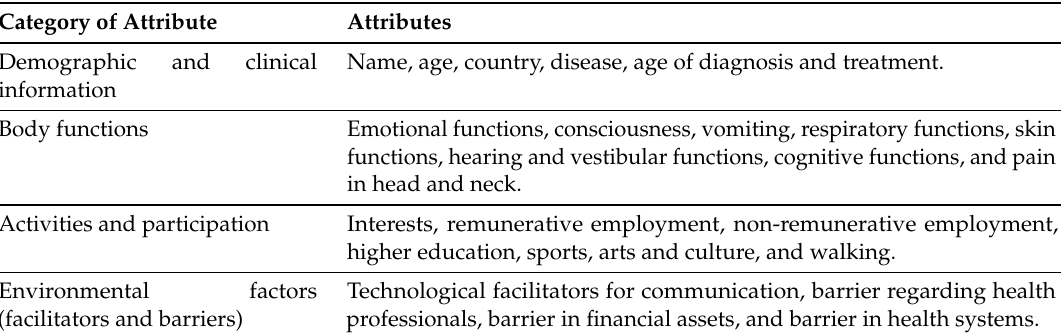
Table 2. Attributes collected in the